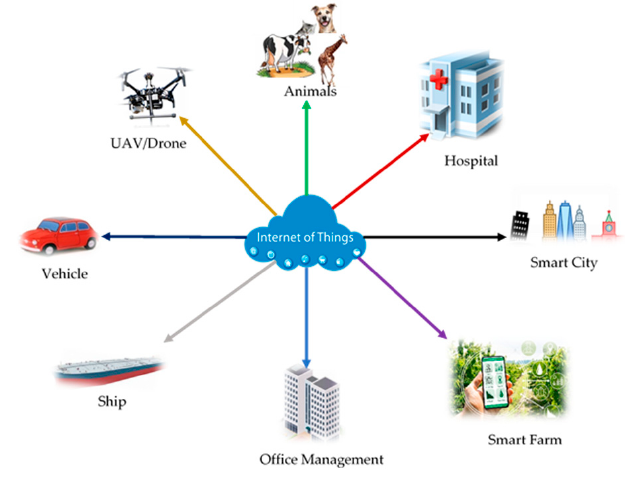
Figure 1. IoT application domains.